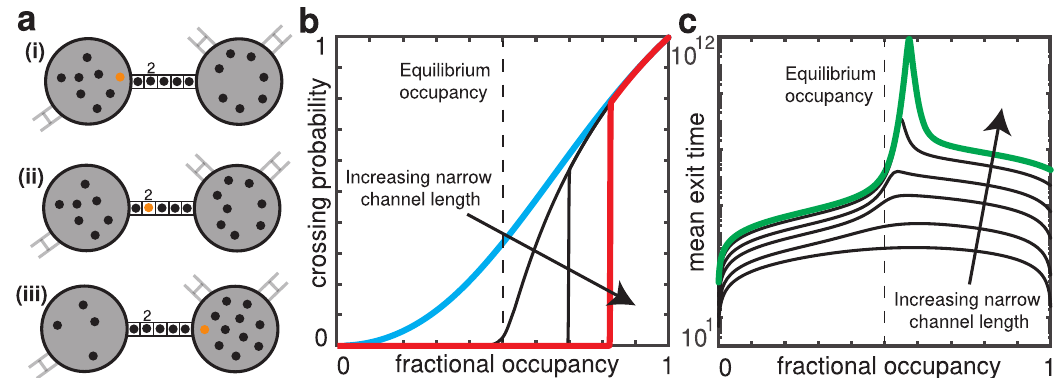
Fig. 4 Narrow channel lengths affect tagged individual dynamics. a Diagrammatic representation of how a tagged individual (orange) transitions from one reservoir (large circles) to another, and the net exchange of background individuals (black) required to do so. (i) The tagged individual is initially in the left-most reservoir. (ii) The tagged individual is considered to have entered the narrow channel only when it reaches the second lattice site denoted by the 2. (iii) The tagged individual has reached the right-most reservoir. b The tagged individual crossing probability p TI (Eq. (6)) for increasing narrow channel lengths K ( i , j ) ∈ {4, 25, 400, 650}. The blue and red lines correspond to channel lengths of 4 and 650, respectively. c The tagged individual mean exit time m K ∈ {5, 10, 25, 50, 100, 150} where the curve corresponding to K = 150 is highlighted in green. The TI (Eq. (8)) for increasing narrow channel lengths ( i , j ) ( i , j ) parameters used in ( b ) and ( c ) are as follows. The two reservoir exit times τ i and τ j are given by τ i = τ j = 0.1 and the number of individuals is given by N = 10 3 G ; K ; τ ð w i